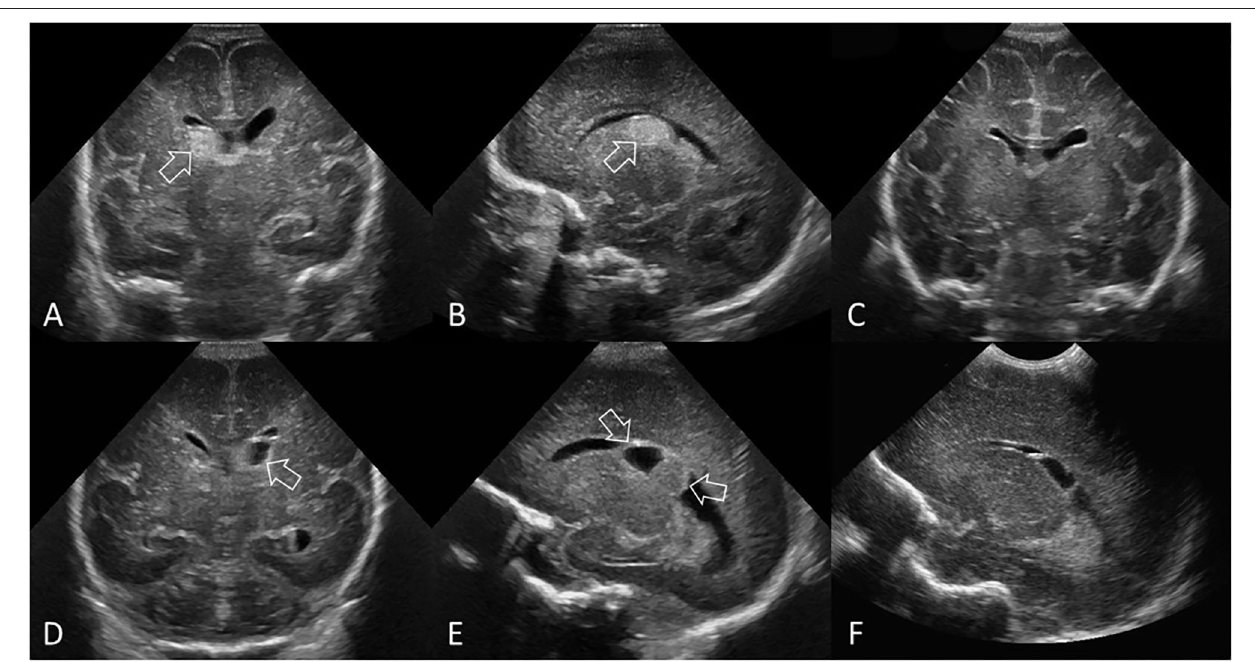
FIGURE 2 | Grade I GMH-IVH. (A–C) Ultrasound scan in a preterm infant (GA 26 weeks) with common pattern of grade I GMH-IVH. (A) Coronal scan at the level of the frontal horns of the lateral ventricles. (B) Parasagittal scan through the right lateral ventricle. The location of the echogenic clot (arrow) at the right caudothalamic notch is typical of grade I GMH-IVH. There is no IVH or ventricular dilatation. (C) Follow up coronal scan 12 weeks later shows complete resolution of the GMH. (D–F) Ultrasound scan in a different preterm infant (GA 27 weeks) with a less common location of grade I GMH-IVH. (D) Coronal scan at the level of the frontal horns of the lateral ventricles. (E) Parasagittal scan through the left lateral ventricle. The clot (arrows) is centered posterior to the left caudothalamic notch, but is still considered a grade I GMH-IVH as there appears to be no blood within the ventricles. The clot is non-uniform in its echogenicity, with the echolucent portion representing